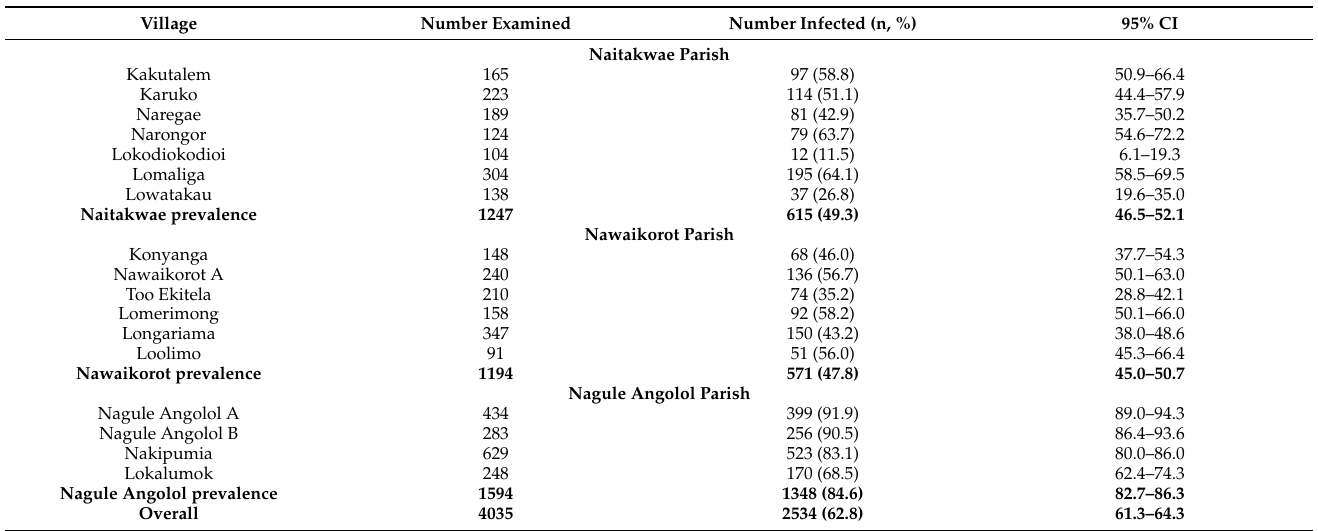
Table 1. Prevalence of human tungiasis in the 17 villages of the three parishes.